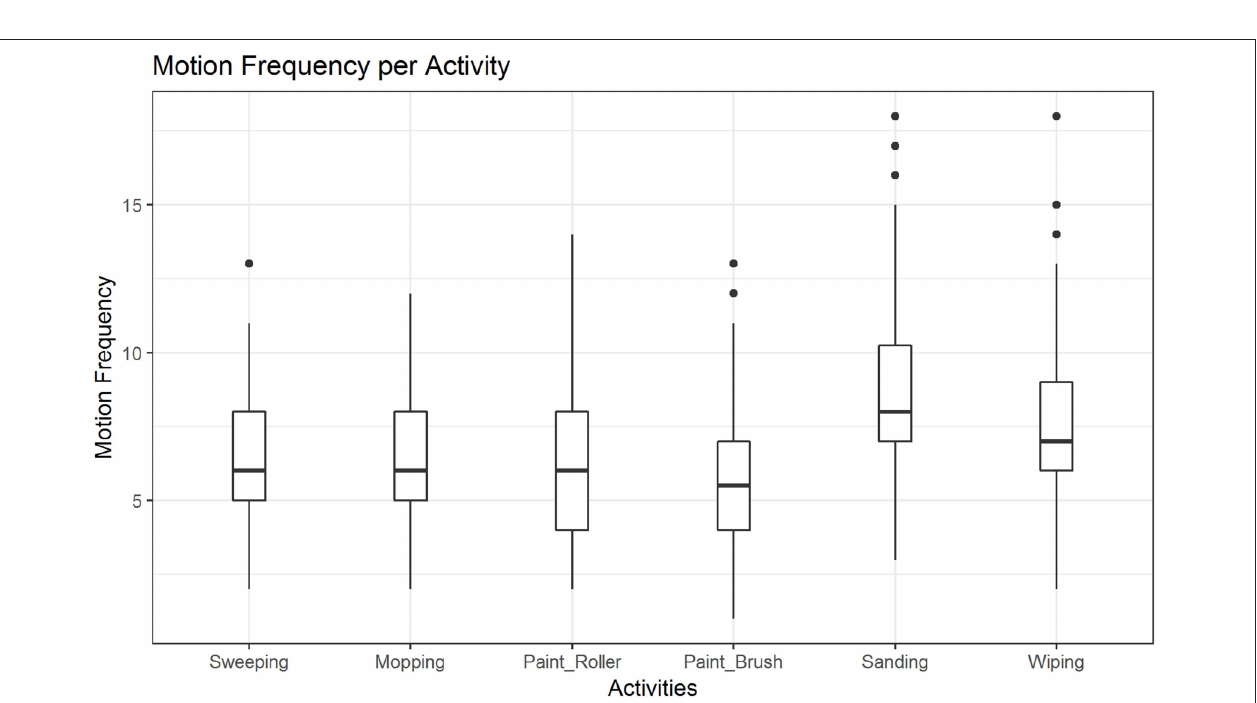
Frontiers in Robotics and AI |